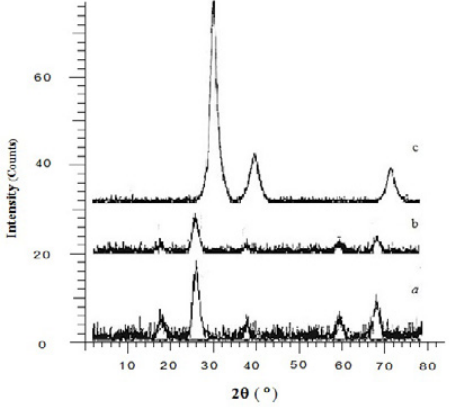
Fig. 5. X-ray diffraction pattern for the ( a ) Fe (b)